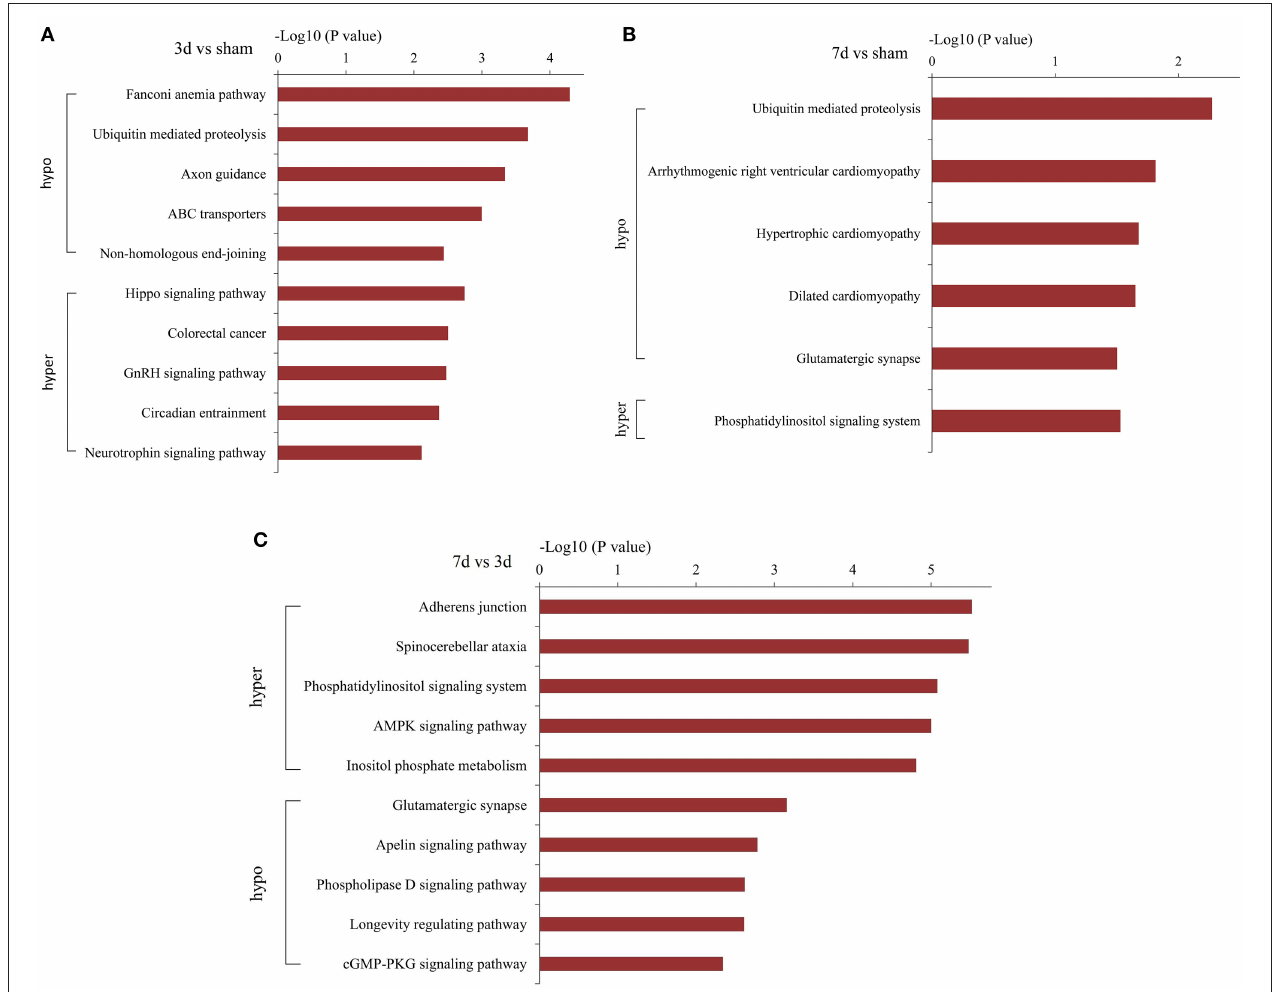
FIGURE 6 | Pathway analyses of the parent genes of differentially m 6 A-modified circRNAs. Pathway analyses of the parent genes of significantly hypermethylated and hypomethylated circRNAs around the infarct cortex in 3d vs. sham (A) , 7d vs. sham (B) , and 7d vs. 3d (C)